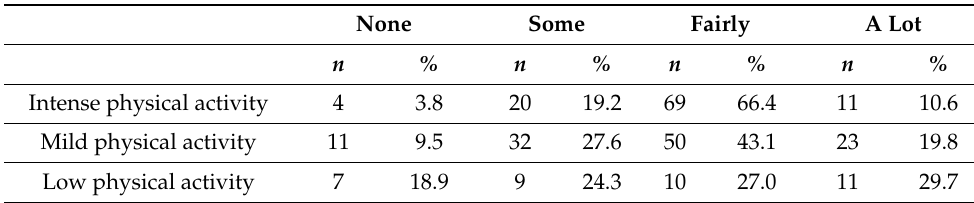
Table 1. Frequencies of the subjective health subscale (CUBRECAVI) related to the level of physical